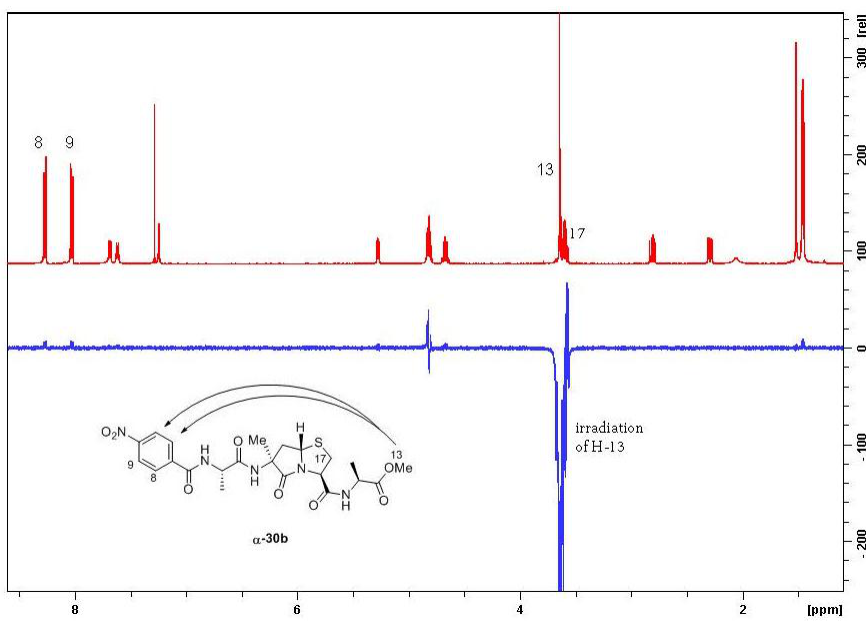
Figure 4. Remote nOe at H-8 and H-9 from irradiation at H-13 of α-30b .